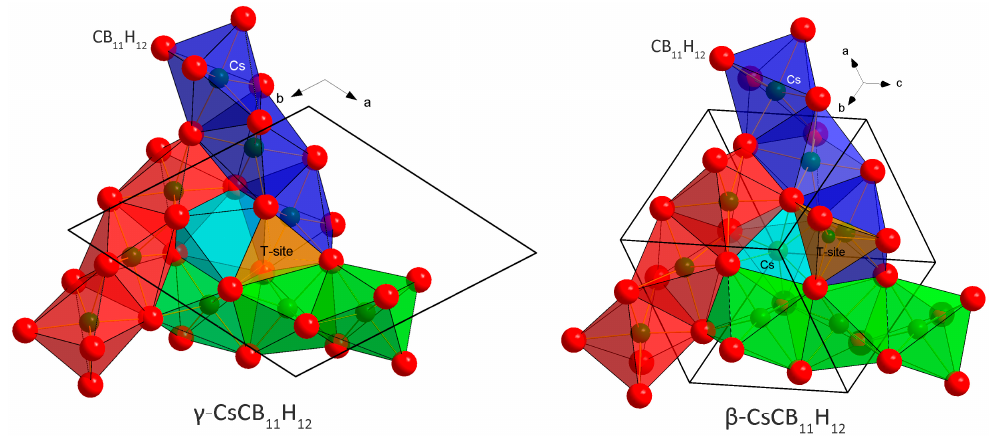
Figure 1. Comparison of the basic structural motif in the γ - ( R 3 c ) and β - ( I 43 d ) polymorphs of CsCB 11 H 12 . The crystal structures in both polymorphs can be constructed from three columns built from face-sharing Cs(CB 11 H 12 ) 6 octahedra (CB 11 H 12 − anions simplified as red spheres) and inter- connected by edges (red, blue, and green columns, respectively). The three columns then share triangular faces with the fourth column (light blue). In the γ -polymorph, this column is empty, but may be occupied by a water molecule in the Cs/H 2 O ratio of 3/1. In the β -polymorph, Cs is randomly distributed inside all four columns with an occupancy of